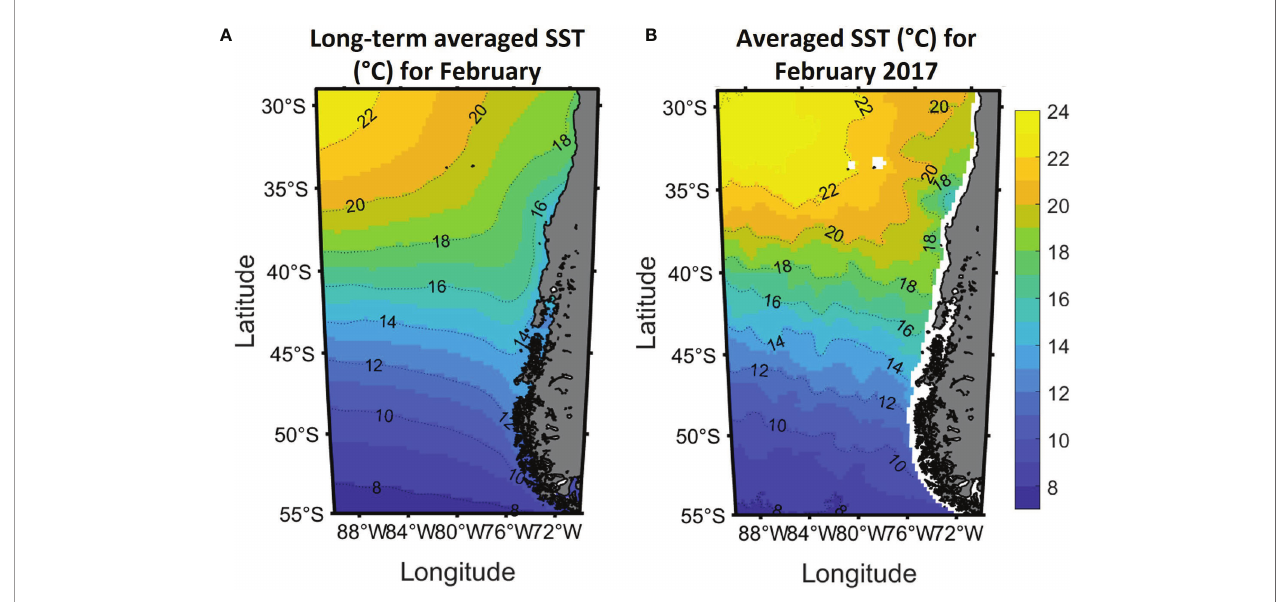
FIGURE 13 | (A) Sea surface temperature (°C) long-term monthly averaged over 1982 to 2020 period for February and (B) monthly average for February